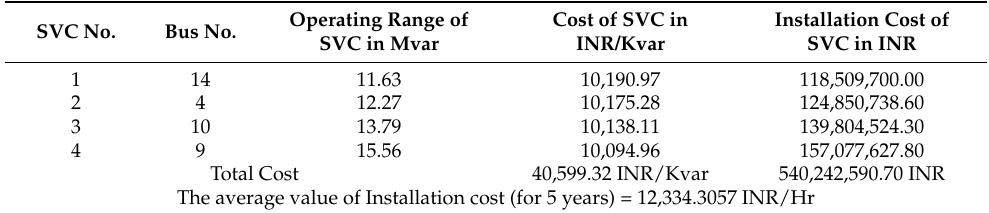
Table 9. Network loss minimization for IEEE 14-Test-Bus Systems with 2 MW solar generation. Bus No.